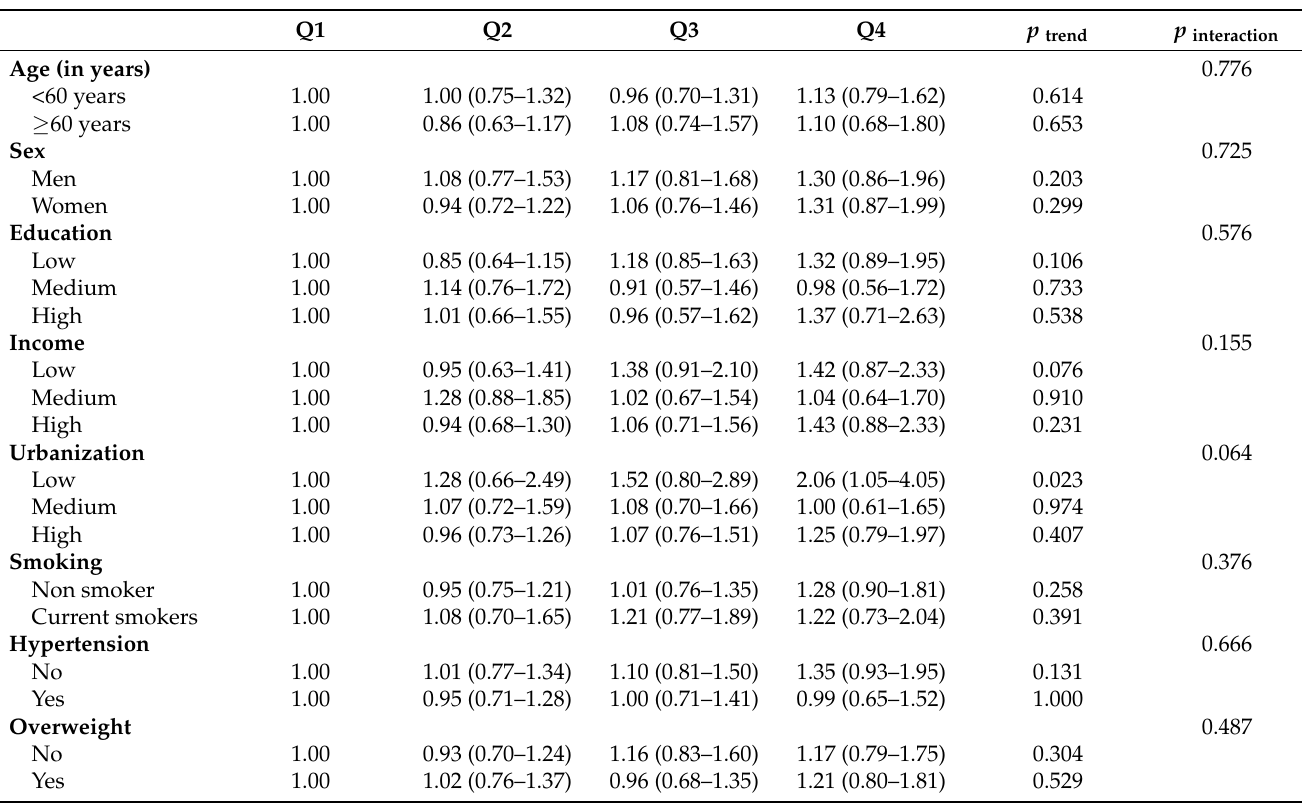
Table 4. Subgroup analyses of the association between the quartiles of plant methionine intake and